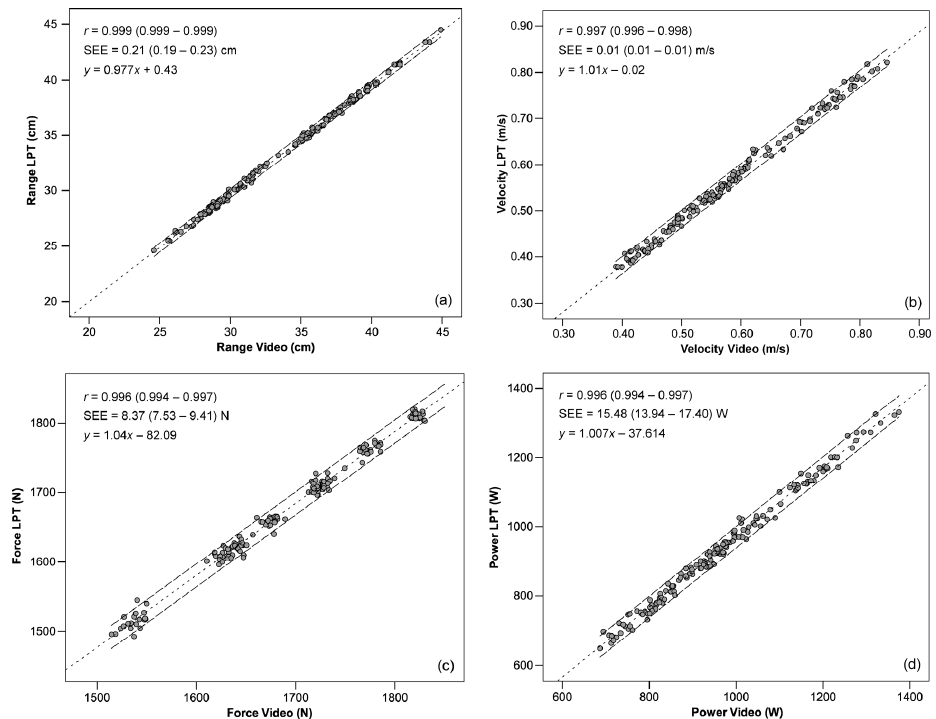
Figure 9. Bland–Altman plots for the measurements of LPT and video systems. Solid central line represents mean between instruments (systematic bias); upper and lower dashed lines show mean ± 1.96 SD (random error); dotted line shows linear regression (proportional bias). ( a ) Range: regression y = –0.02 x +0.41 cm, r 2 = 0.22; ( b ) velocity: regression y = 0.01 x –0.02 m/s, r 2 = 0.03; ( c ) force: regression y = 0.04 x –88.13 N, r 2 = 0.17; ( d ) power: regression y = 0.01 x –41.71 W, r 2 = 0.02. Sensors 2021 , 21 , x FOR PEER REVIEW